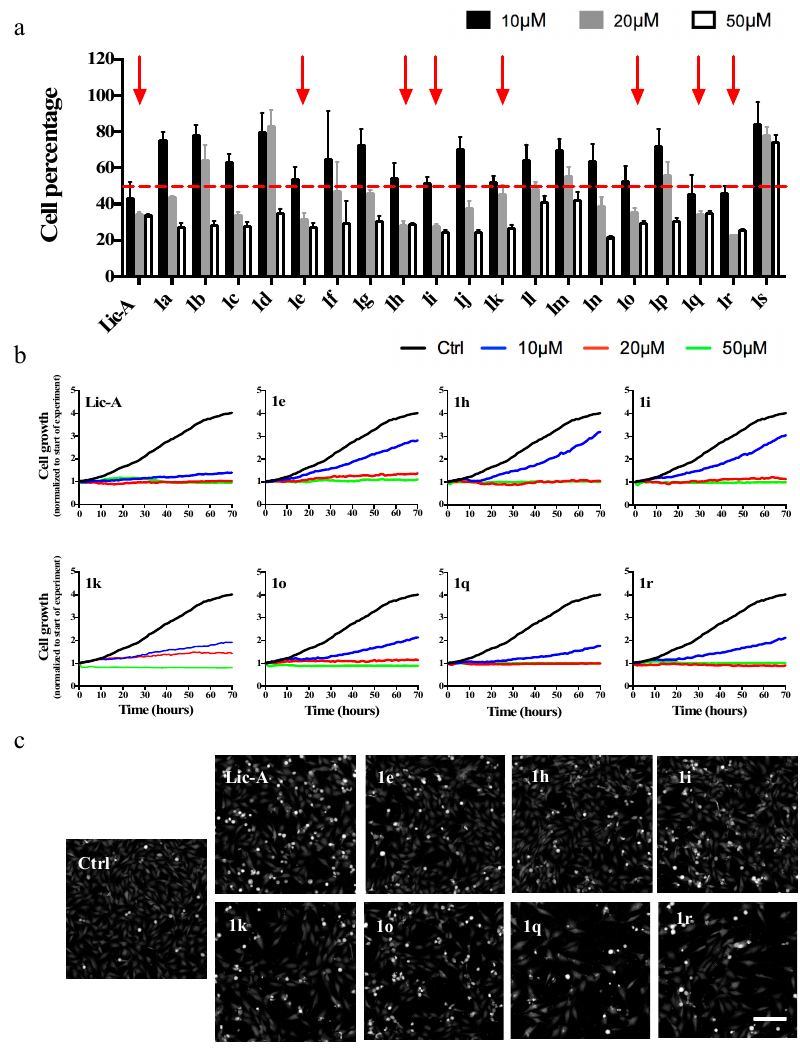
Figure 2. Effects of chalcones on MG63 cell proliferation and cell death. Cells were incubated with 10, 20, and 50 µM of each compound and analyzed during the following 72 h. ( a ) Number of cells, expressed as percentage with respect to the control, obtained by QPI technology at 48 h. ( b ) Cell growth profiles reported as cell number fold increase, along the 72 h of incubation with the most active compounds. Data were normalized for the effective number present at the beginning of ex- periment. ( c ) Representative quantitative phase images recorded at 48 h after treatment with the selected derivatives at 10 µM concentration. Scale bar 200 µm.